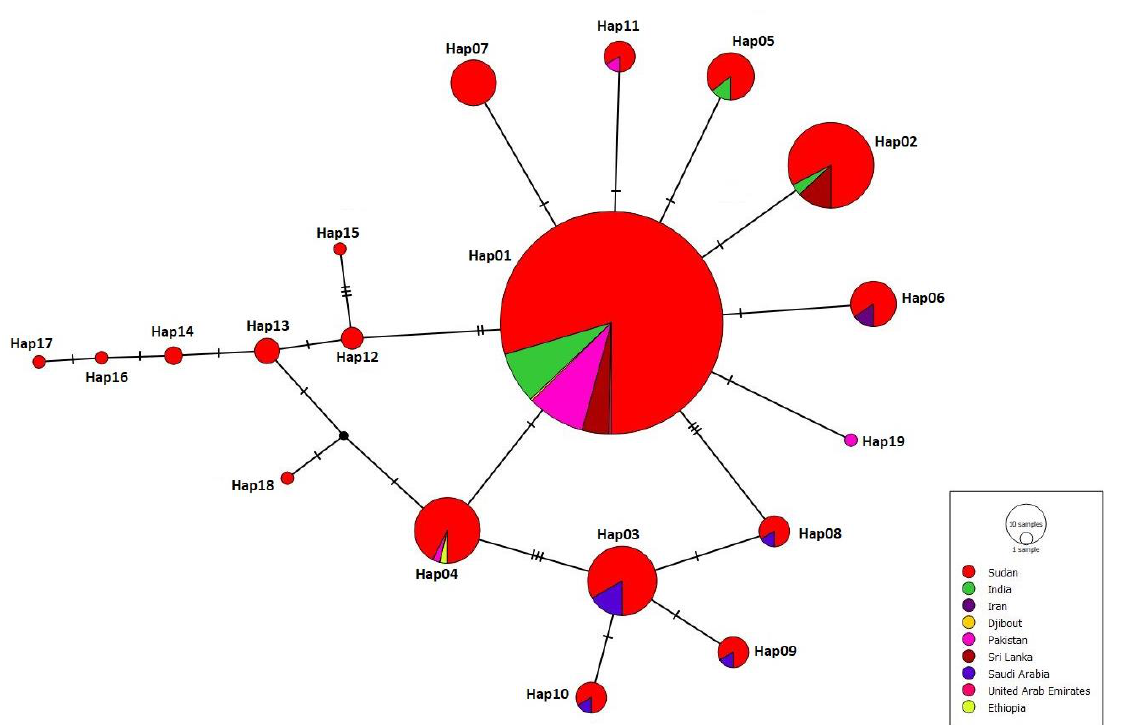
Figure 5. Median-joining haplotype network of the 19 Sudanese An. stephensi haplotypes and worldwide An. stephensi sequences. Haplotypes of each region are presented in color code. Black dashes between the haplotype lines represent the number of substitutions.